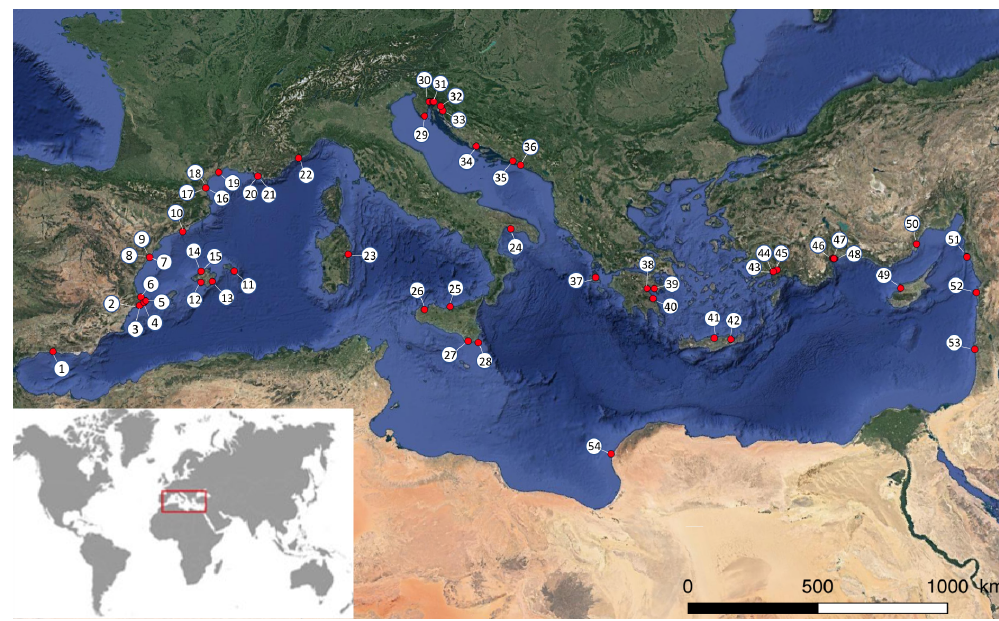
Figure 1. Location of the 54 SGD springs used for this study. The SGD springs shown in the figure are described in Bakalowicz (2018), Basterretxea et al. (2010), Fleury et al. (2007), Garcia-Solsona et al. (2010) and Mejías et al. (2012). © Google Earth